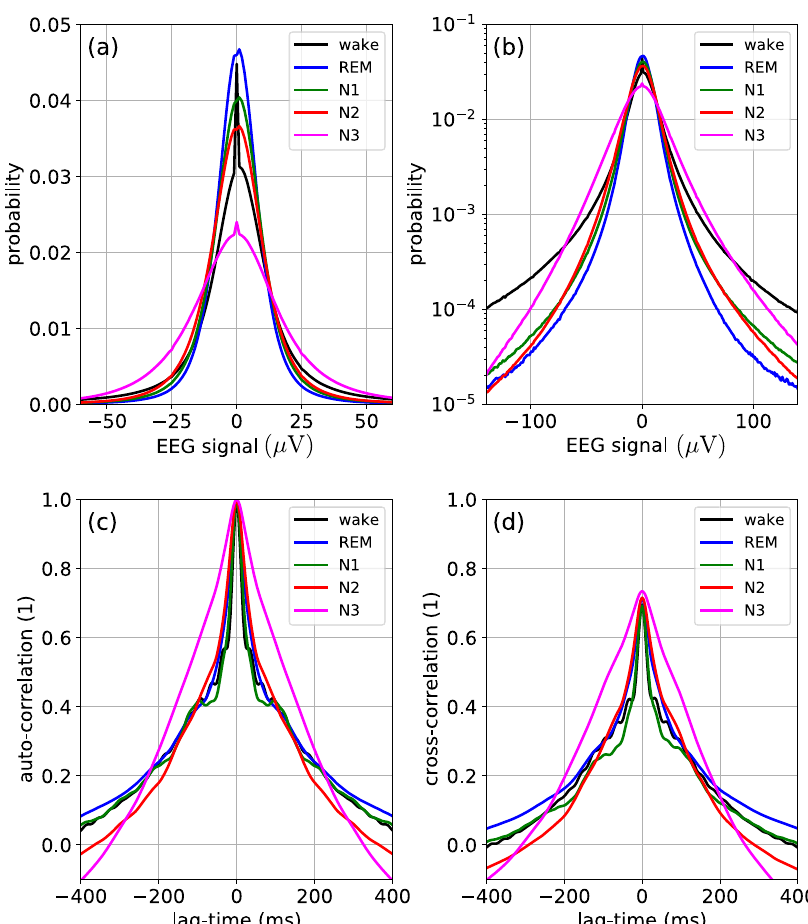
Fig. 1 Statistical properties of raw EEG signals. Statistical properties of the raw EEG signals. a Linear plot of the probability density distribution. b Semi- logarithmic plot of the probability density distribution. c Autocorrelation function. d Cross-correlation function between channels 1 and